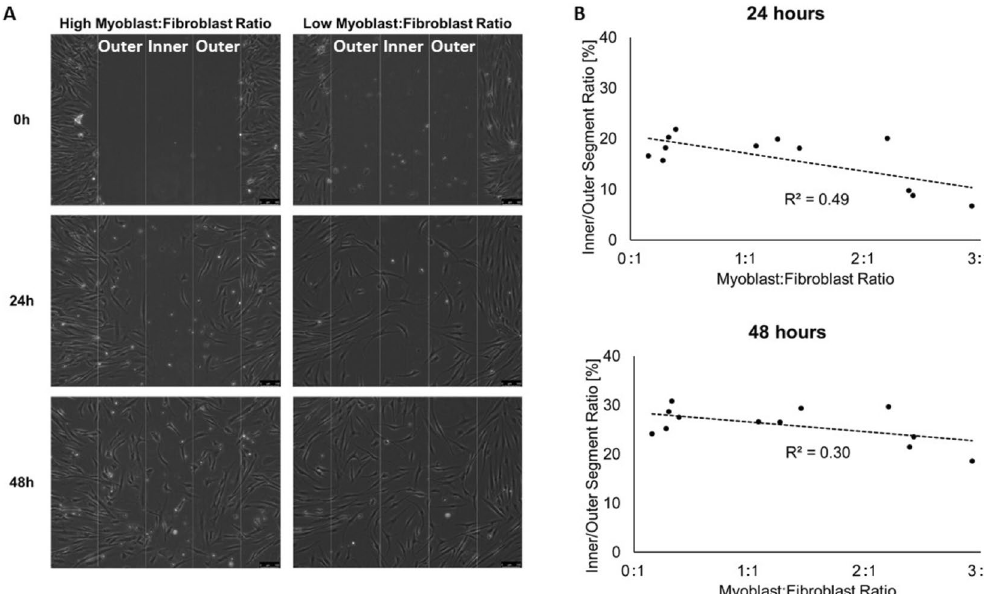
Figure 4. ( A ) Representative images for cell migration of muscle cells with a high myoblast:fibroblast ratio (2.4; left) and with a low myoblasts:fibroblast ratio (0.3; right) into the artificial wound. The wound area is about 900 µm in width and split into 3 × 300 µm segments (one inner and two outer segments). Magnification is × 10.5, and scale bar is 100 µm. ( B ) Inverse correlations between the myoblast:fibroblast ratio and the migration dynamics of 12 different primary muscle stem cells 24 h (P = 0.011) and a trend 48 h (P = 0.064) after the artificial wound healing assay. This figure ( B ) was produced in Microsoft Excel 2016.